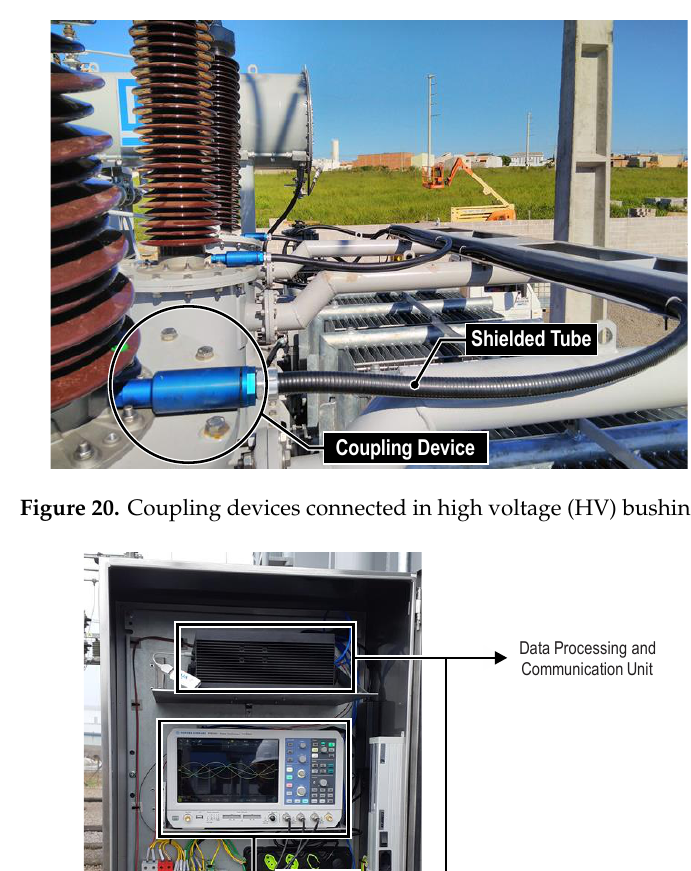
Figure 22. Signal with PD acquired from the test tap of bushing of phase A. The voltage signal measured had components in addition to the 60 Hz sinusoidal signal, which included harmonics, interharmonics, and partial discharges. Particularly with respect to the PDs, it is worth noting that their activities were perceived due to the low-amplitude and high-frequency pulses present in 1–2.5, 5–6, 9–11, 13.4–14.6, 17.5–18.6, and 22–23 ms, as indicated by the circled areas in Figure 22. In a broader analysis, the partial discharges could also be perceived due to their distribution in the frequency spectrum. In this sense, when transforming the captured signal to the frequency domain, as shown in Figure 23, it is possible to observe that the PDs are evident in a high-frequency band spread mainly in the following intervals: 120–500 kHz, 0.9–1.5 MHz, and 2.2–2.5 MHz.